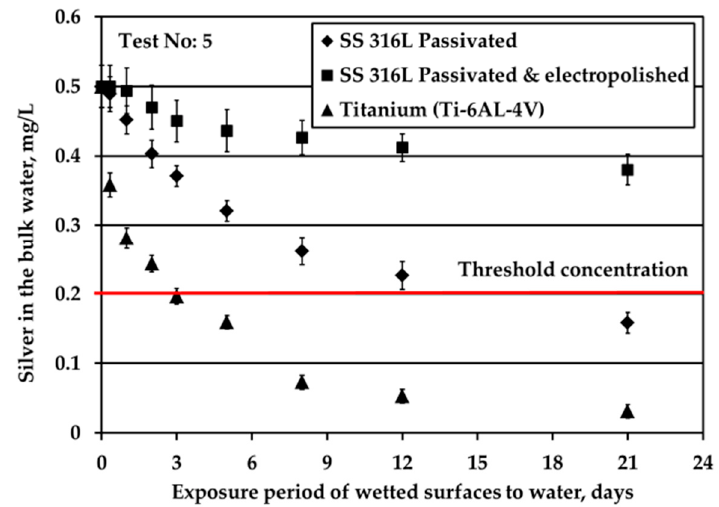
Figure 3. Silver loss from the bulk potable water for all three materials under continuous water flow − 1 conditions (S/V = 0.1 cm − 1 ). conditions (S / V = 0.1 cm